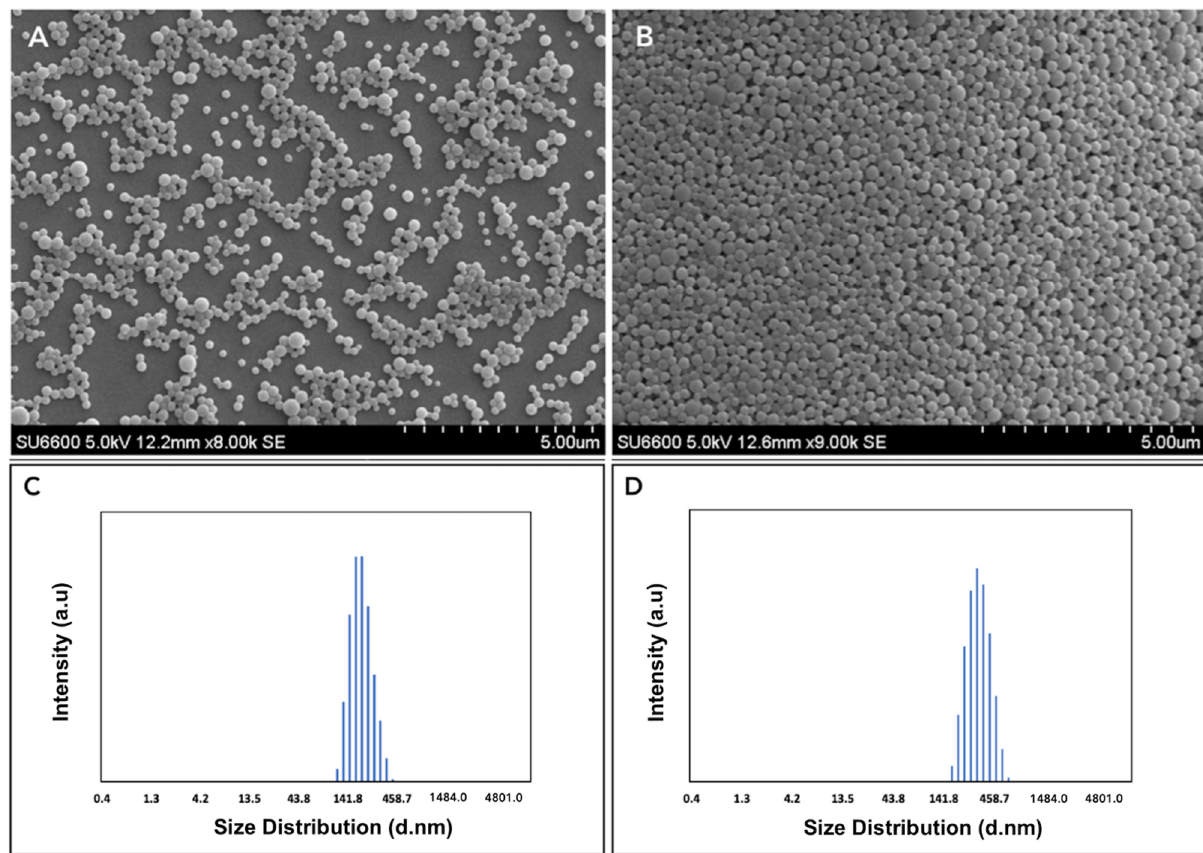
Figure 1. ( A , B ) SEM image of curcumin-Bioperine PLGA NPs 1:0.2:10 and 1:1:10 (at scale 5.00 µ m). ( C , D ) Size distribution of curcumin-Bioperine PLGA NPs 1:0.2:10 and 1:1:10, respectively.